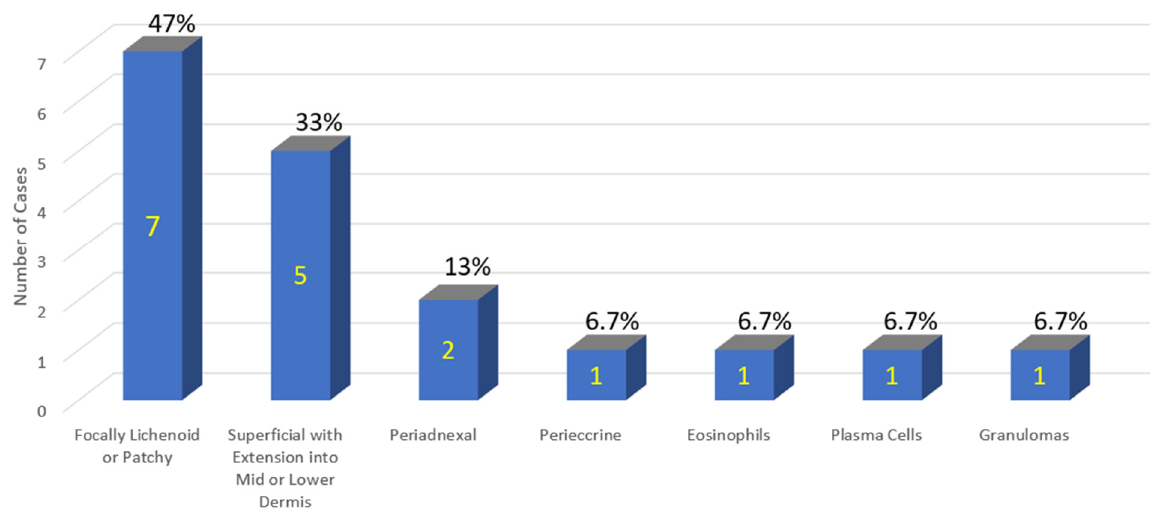
Figure 12. COVID-19 vaccine-induced lichenoid eruptions—case series of 15 patients. Shown on the x-axis are atypical features of the epidermis.